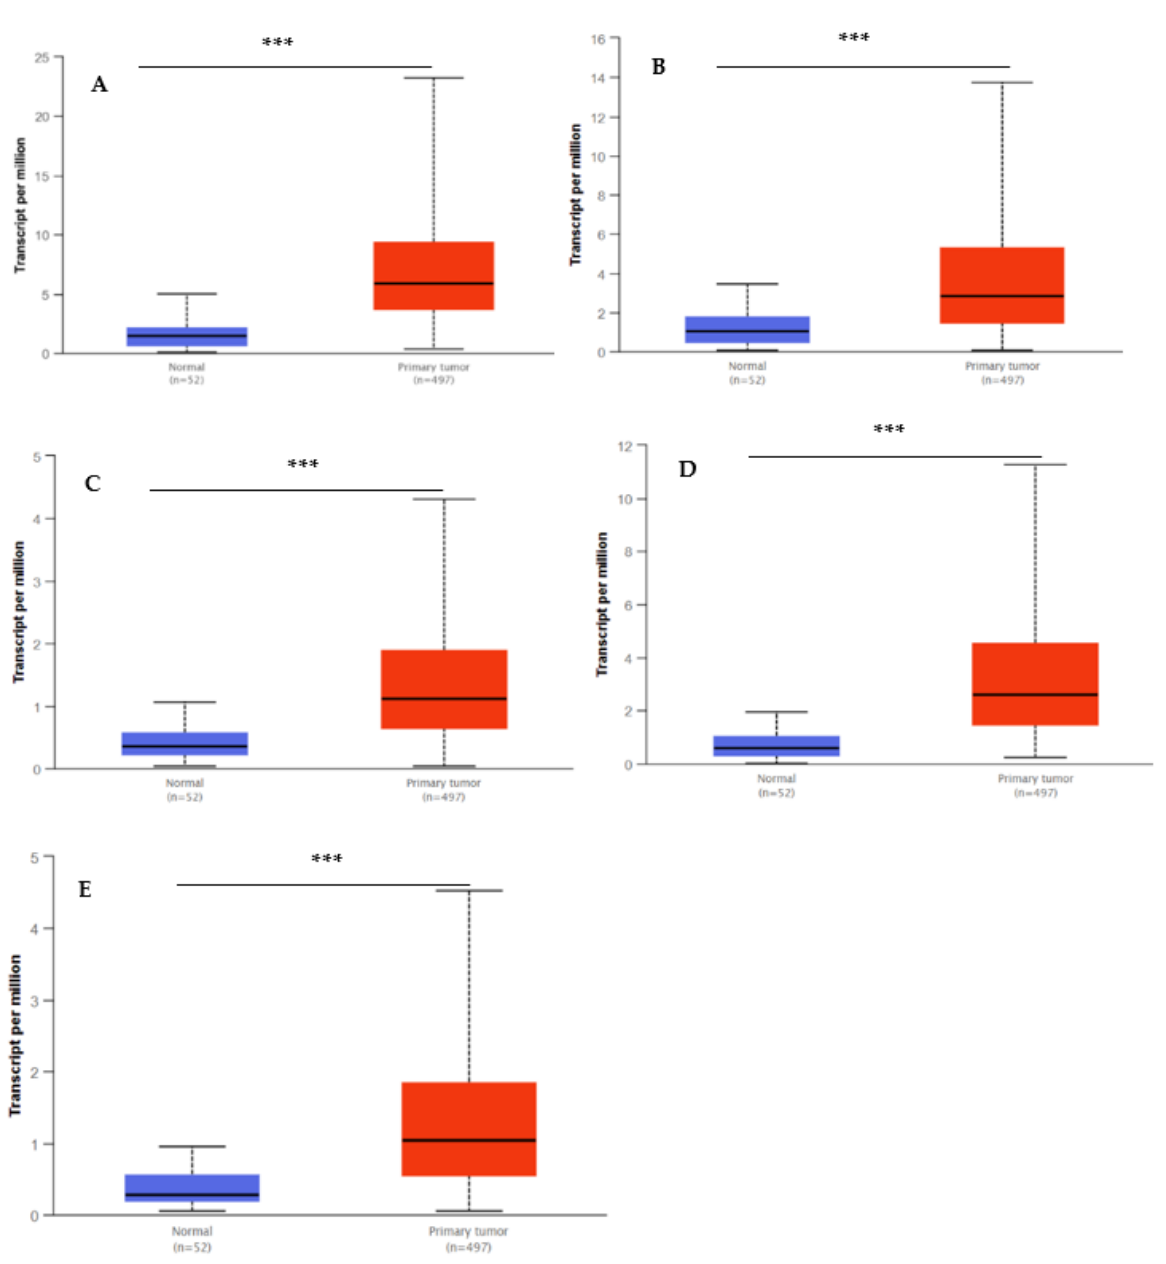
Figure 8. Box whisker plots indicating the expression of five hub genes in PCa samples. ( A ) UBE2C; ( B ), TOP2A; ( C ) BUB1B; ( D ) RRM2; and ( E ) CENPF were identified by MCODE and verified at the protein level by UALCAN, which came from the TCGA project. Data are mean ± SE. *** p <